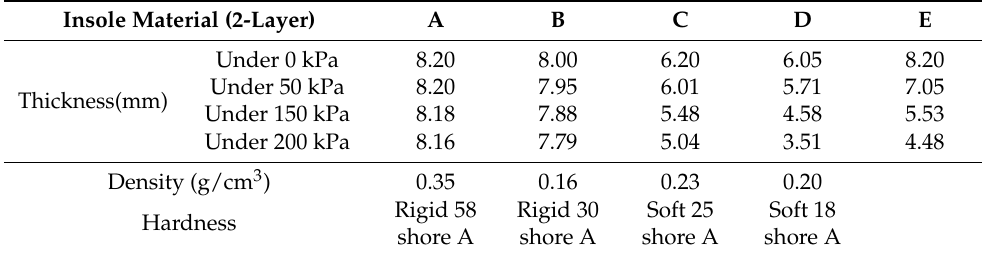
Table 1. Physical properties of the studied insole materials.